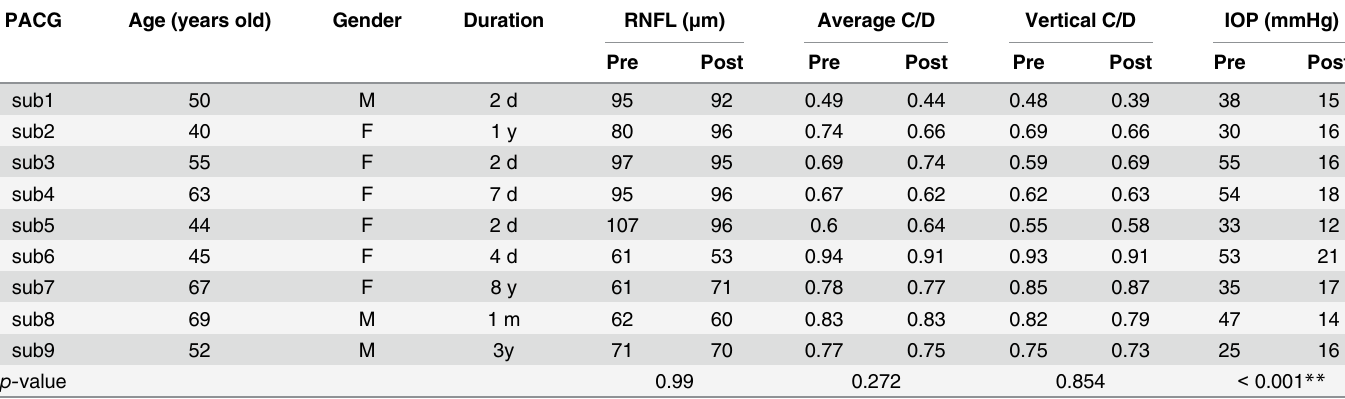
Table 2. Ophthalmological assessments of patients before (Pre-PACG) and after (Post-PACG)